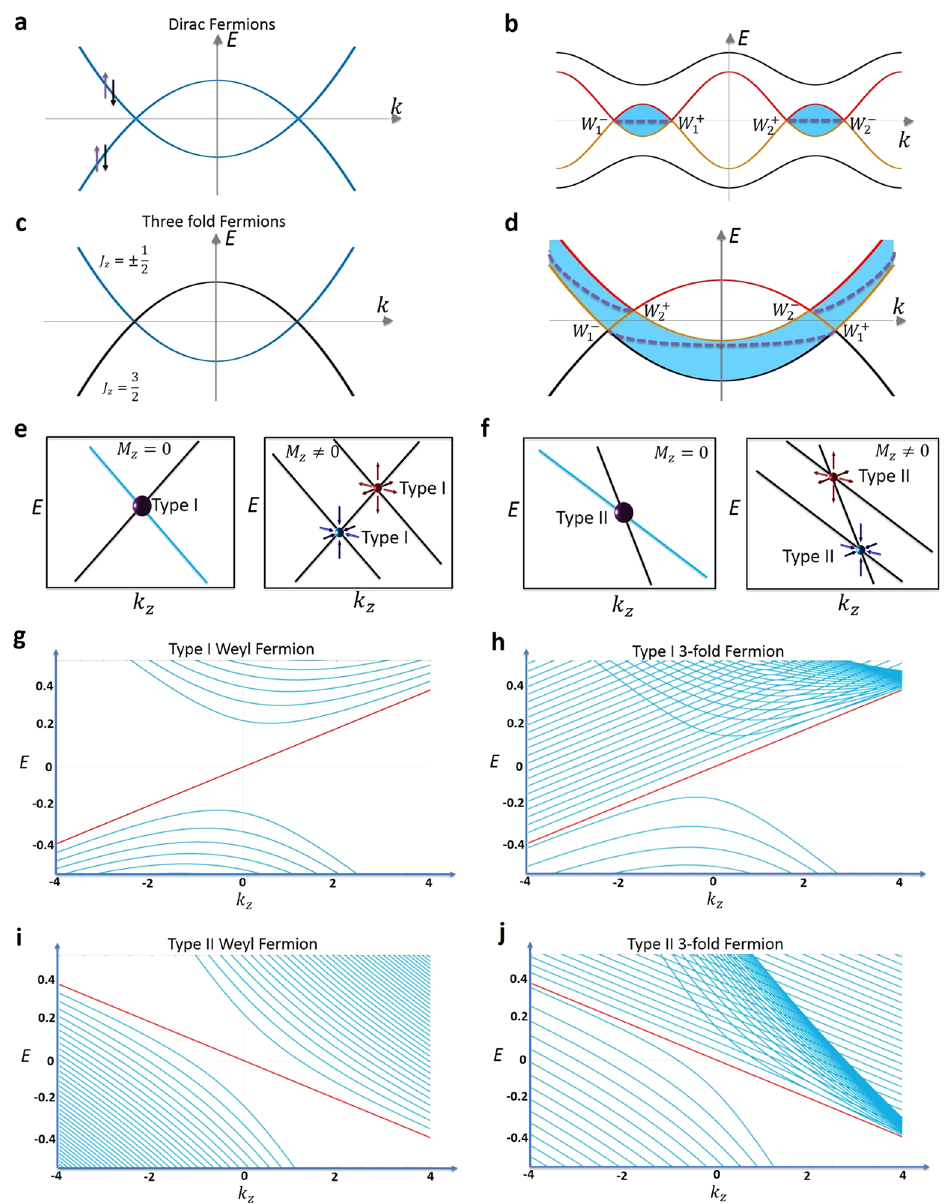
Figure 3. Zeeman coupling and Landau level spectrum. ( a ) Cartoon illustration of two doubly-degenerate bands crossing. The four-fold degenerate crossing point describes Dirac fermion quasiparticles. ( b ) In the presence of a Zeeman field, the two Dirac fermions described in ( a ) split into 2 pairs of Weyl fermions (i.e. → + + − W W ). All pairs of generated Weyl fermions arise from the crossing between two singly-degenerate 1 1 bands (red and yellow). The blue shaded region corresponds to section in the Brillouin zone with a non-zero Chern number. ( c ) Cartoon illustration of a doubly-degenerate band (blue) crossing a singly-degenerate band to create a pair of triply-degenerate fermions at the crossing points. ( d ) In the presence of a magnetic field, the doubly-degenerate band splits into two singly-degenerate bands, which then cross the singly-degenerate band at two different locations. Because the pair of generated Weyl fermions are not the crossing points between the same two singly-degenerate bands, the blue shaded area with a non-zero Chern number is distinctly different from the Dirac fermion case presented in ( b ). ( e , f ) A cartoon schematic for the splitting of a triply-degenerate type-I and type-II fermion (purple sphere) in the absence (left panels) and presence (right panels) of a  respectively. ( g , i ) Landau level spectrum for type-I (left panel) and type-II (right panel) Weyl fermions, respectively, for a magnetic field along the z direction. Type-I Weyl fermions produce a gapless chiral Landau level spectrum, and realize the chiral anomaly of quantum field theory. Type-II Weyl fermions have a gapless chiral Landau level spectrum only when the magnetic field points along certain directions, and, therefore, realize an anisotropic chiral anomaly. ( h,j ) Landau level spectrum for Class α triply-degenerate fermions of type-I ( h ) and type-II ( j ), respectively. The zeroth order Landau level band is in